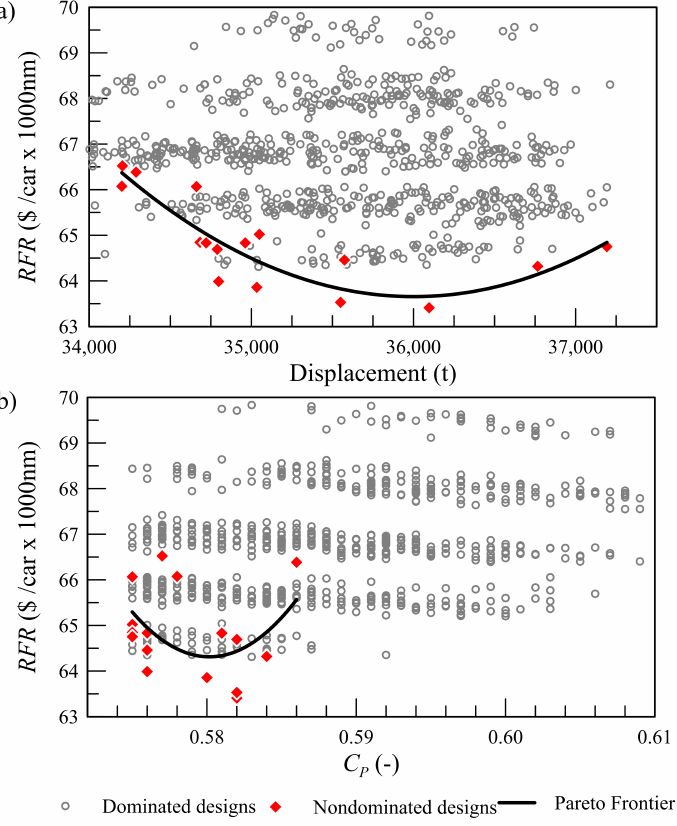
Figure 9. Distribution of the RFR of the feasible LCTC design alternatives as a function of displace- ment ( a ) and prismatic coefficient ( b